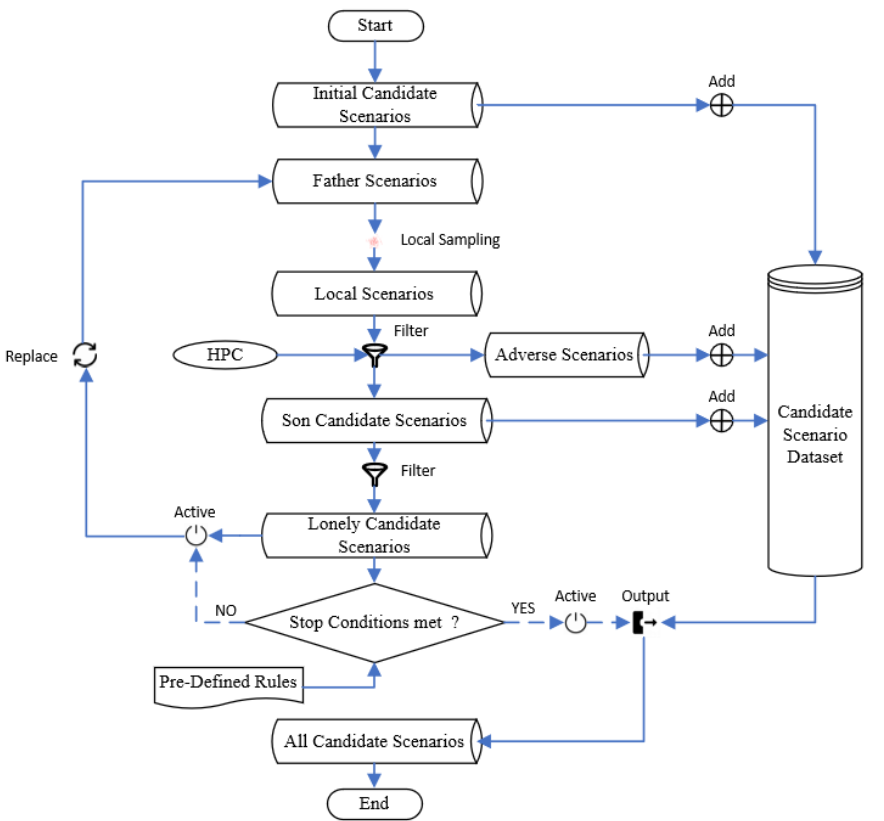
Figure 6. Flow chart of deriving more candidate scenarios based on a small set of candidate scenarios.